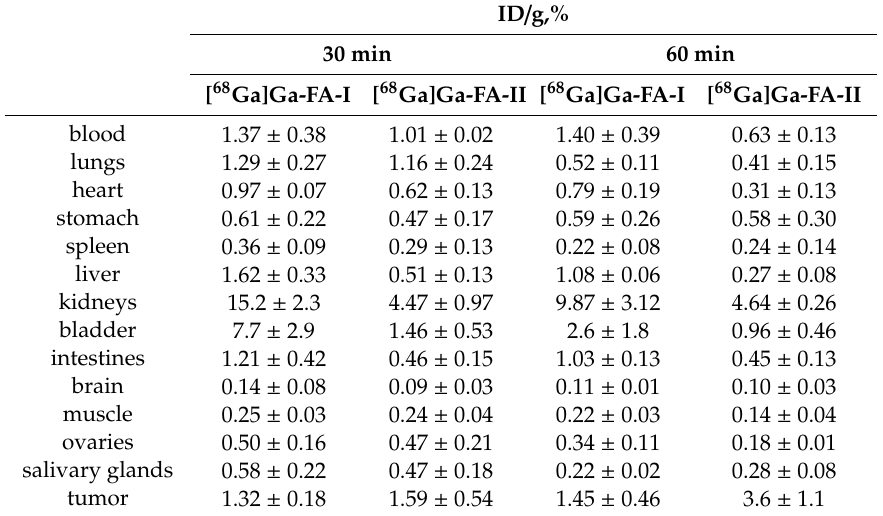
Table 3. Biodistribution of [ 68 Ga] Ga-FA-I and [ 68 Ga] Ga-FA-II in KB-tumor bearing BALB / c nude mice ( mean ± SD, n = 5